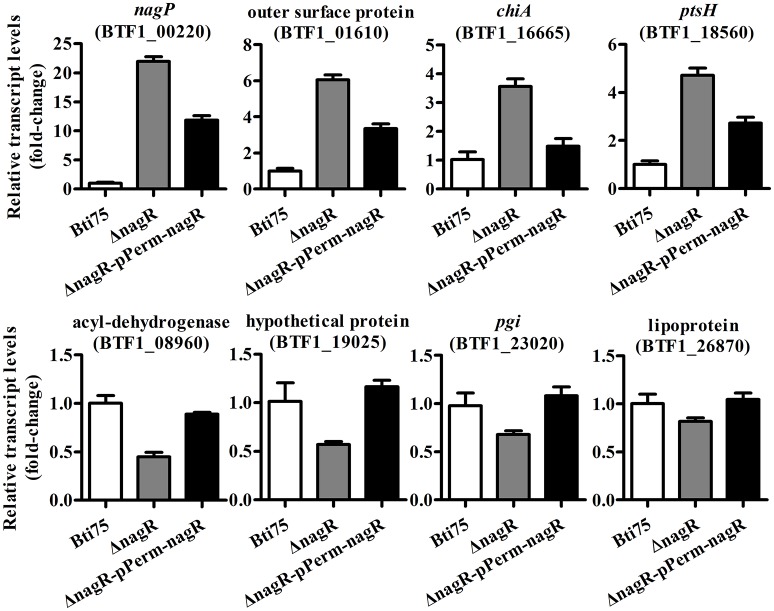
qRT-PCR validation of Bti75ΔNagR, Bti75ΔnagR-pPerm-nagR, and the wild-type (WT). Expression profiles of selected random DEGs (BTF1_00220, BTF1_01610, BTF1_16665, BTF1_18560, BTF1_08960, BTF1_19025, BTF1_23020, BTF1_26870) as determined by qRT-PCR.